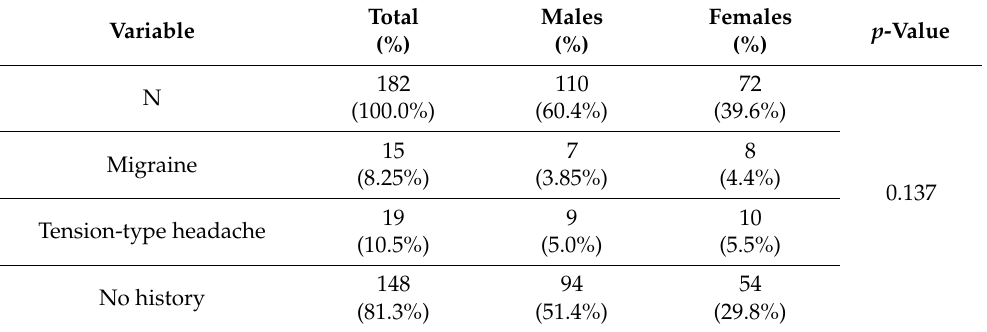
Table 2. Prevalence of migraine and tension-type headache among survey respondents.